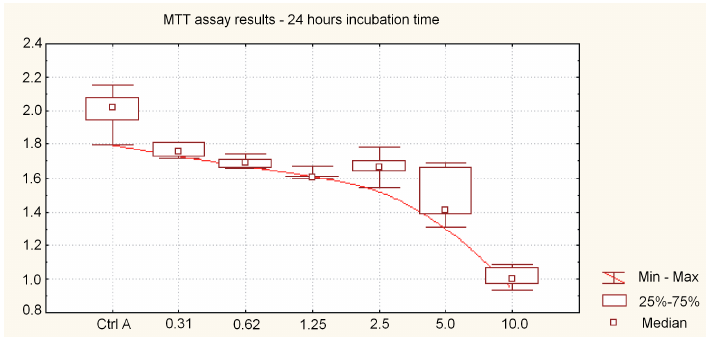
Figure 3. Assessment of cell viability after treatment with various nanosilver particle concentrations during 24 h. Cell viability compared to the control (untreated cells) was plotted against the absorbance at 570 nm. MTT assay results after 24 h of incubation representing absorbance values (median, min-max) for 0.31 μ g/mL to 10 μ g/mL AgNP concentrations. AgNPs inhibited the cells’ growth in a dose-dependent manner. Differences of mean absorbance values between different AgNPs concentrations were highly significant ( p < 0.01, ANOVA Friedman ANOVA test).